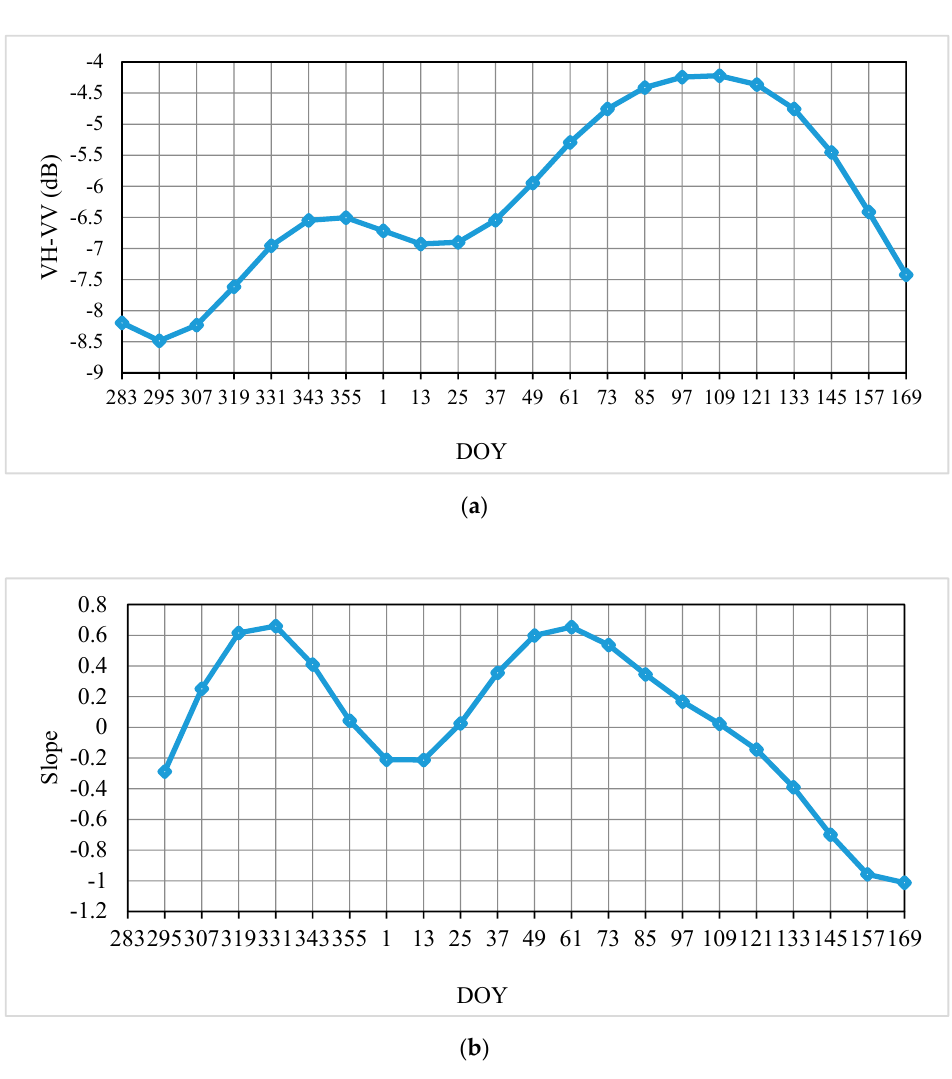
Figure 7. ( a ) The σ d (VH-VV) time series from 9 October 2016 (DOY 283) to 30 June 2017 (DOY 169). ( b ) The change in the slope of the σ d time